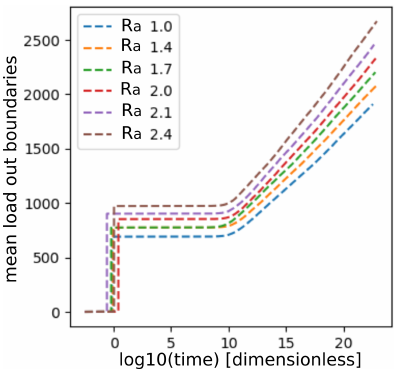
Figure A2. Evolution of the mean load dissipated from the system through the border as a function of R a